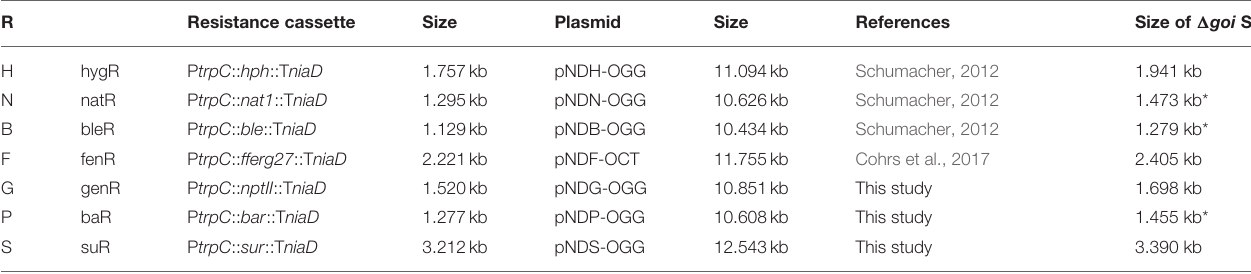
TABLE 2 | Generation of replacement fragments with resistance cassettes by single-step PCR.